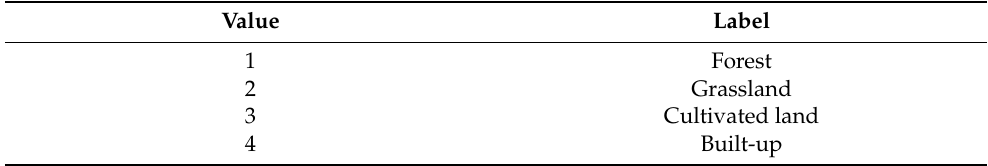
Table 1. The correspondence between value and label in the land use and land cover data. Value Label 1 Forest 2 Grassland 3 Cultivated land 4